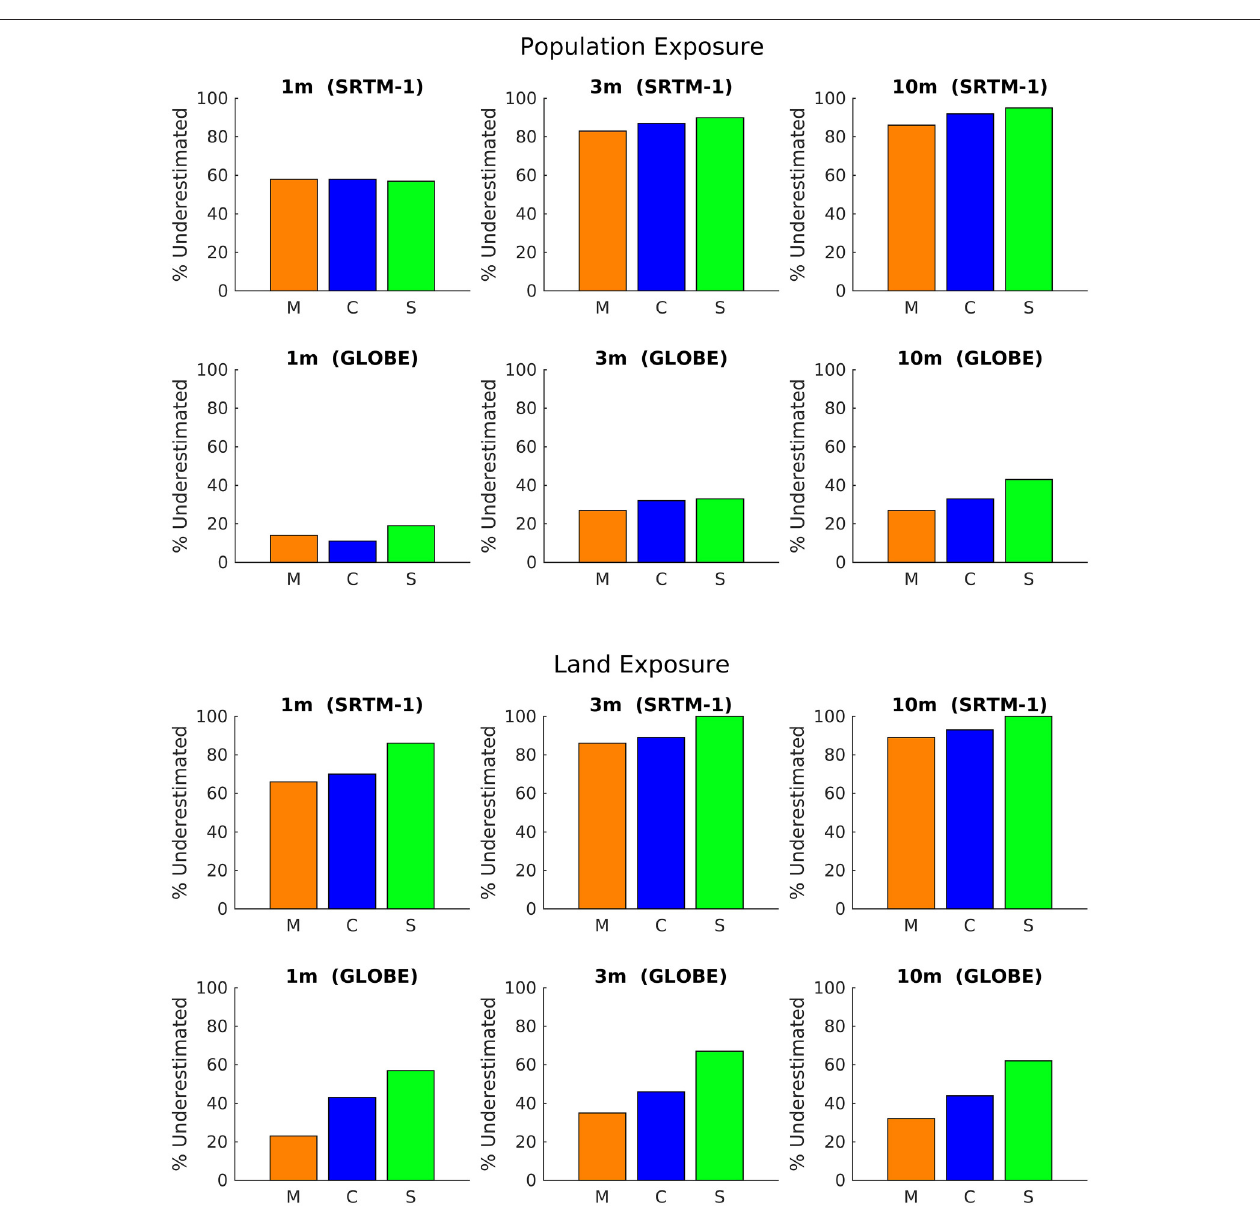
FIGURE 1 | Bar graph of percent of places underestimating population (A) and land (B) exposure under SRTM-1 and GLOBE, across Municipalities (M, orange), Counties (C, blue), and States (S, green).